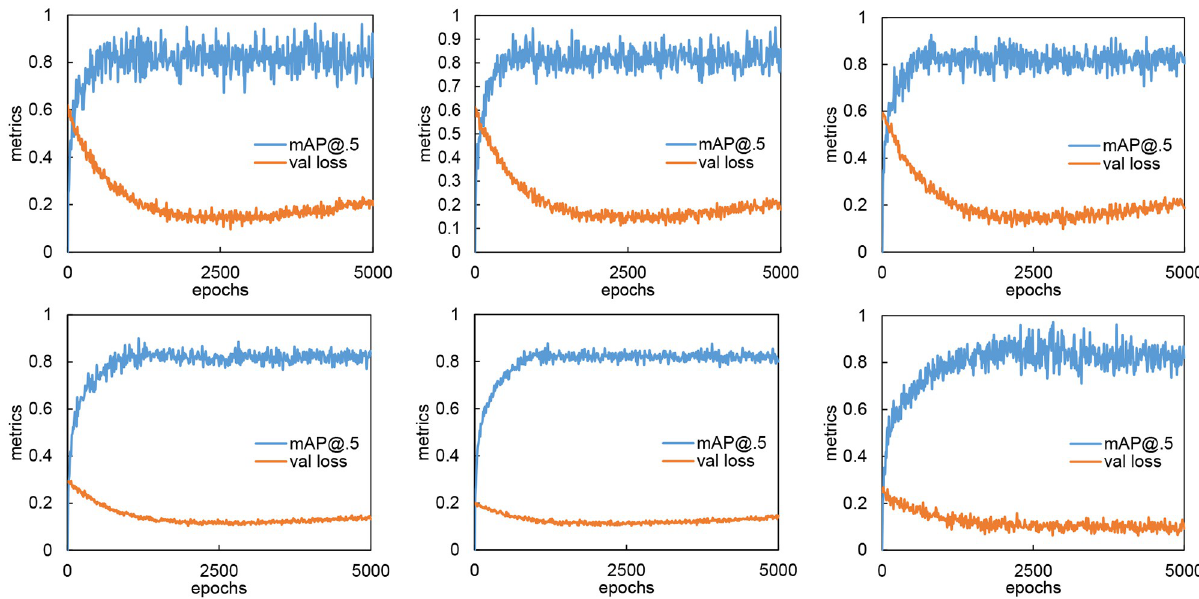
Fig 5. Detection performances and validation losses. The first row from left to right are YOLOv5s, YOLOv5s6, and YOLOv5m. The second row from left to right are FasterRCNN R50, FasterRCNN R101, and